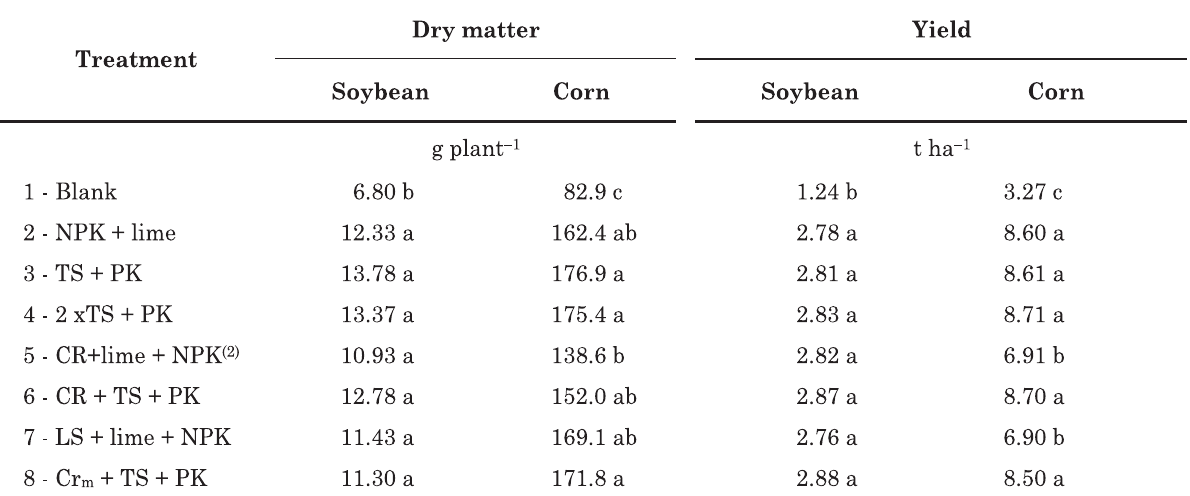
Table 5. Plant dry matter production and grain yield in the 1999/2000 growing